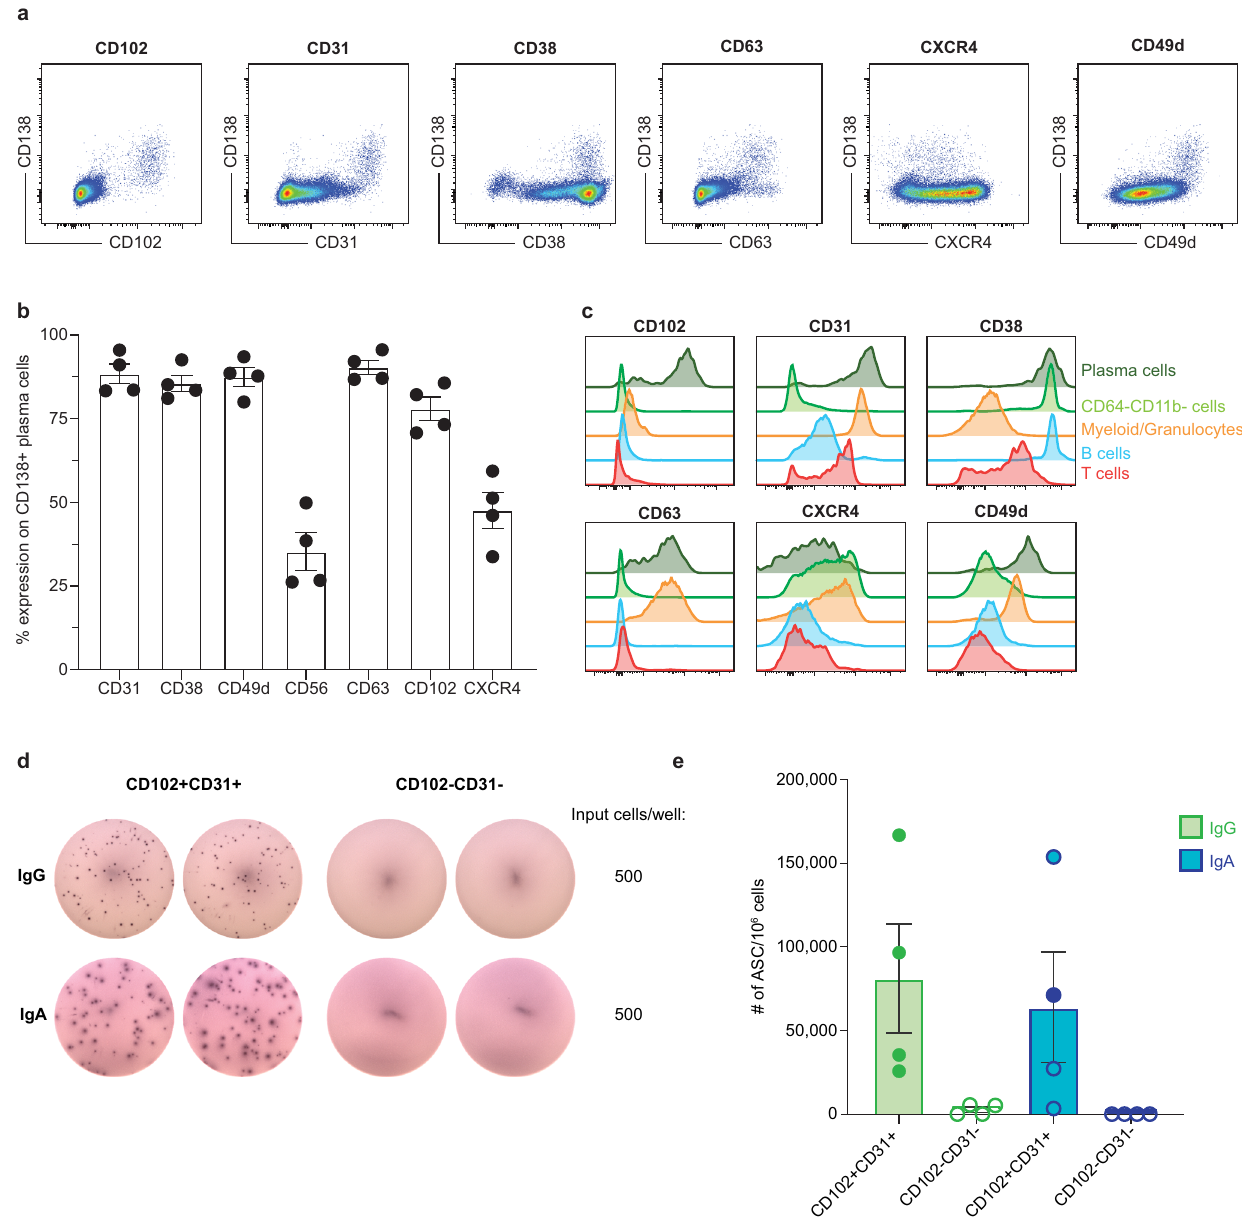
Fig. 4 CD102 and CD31 enable enrichment of antibody-secreting cells independent of CD138. a Representative fl ow plots of marker expression for CD102, CD31, CD38, CD63, CXCR4, and CD49d. Cells were previously gated as CD3-CD20-CD64-CDllb- single lymphocytes. b Quanti fi cation of marker expression on CD138 + plasma cells in rhesus macaque bone marrow; n = 4 biologically independent animals. c Representative histograms of indicated marker expression for various immune cell lineages identi fi ed in the bone marrow of rhesus macaques. Dark Green = plasma cells (CD138 + CD3 − CD20 − CD64 − CDllb − single lymphocytes), light green = non-B/T (CD3 − CD20 − ) CD64 − CD11b − cells, orange = non-B/T (CD3 − CD20 − ) CD64 + CD11b + cells, blue = B cells (CD20 + cells), red = T cells (CD3 + cells). d Representative images of ELISPOT wells coated with either anti-IgG or anti-IgA. CD102 + CD31 + or CD102 − CD31 − cells from rhesus macaque bone marrow were plated in duplicate and serial diluted (2- fold) down the plate. Loadings for the top dilution are indicated. e Quanti fi cation of total-IgG and total-IgA ELISPOTs for the unsorted, CD102 + CD31 + , and CD102 − CD31 − populations. Quanti fi cation of the number of antibody-secreting cells (ASC) per million input cells. Error bars depict standard error of the mean. n = 4 biologically independent